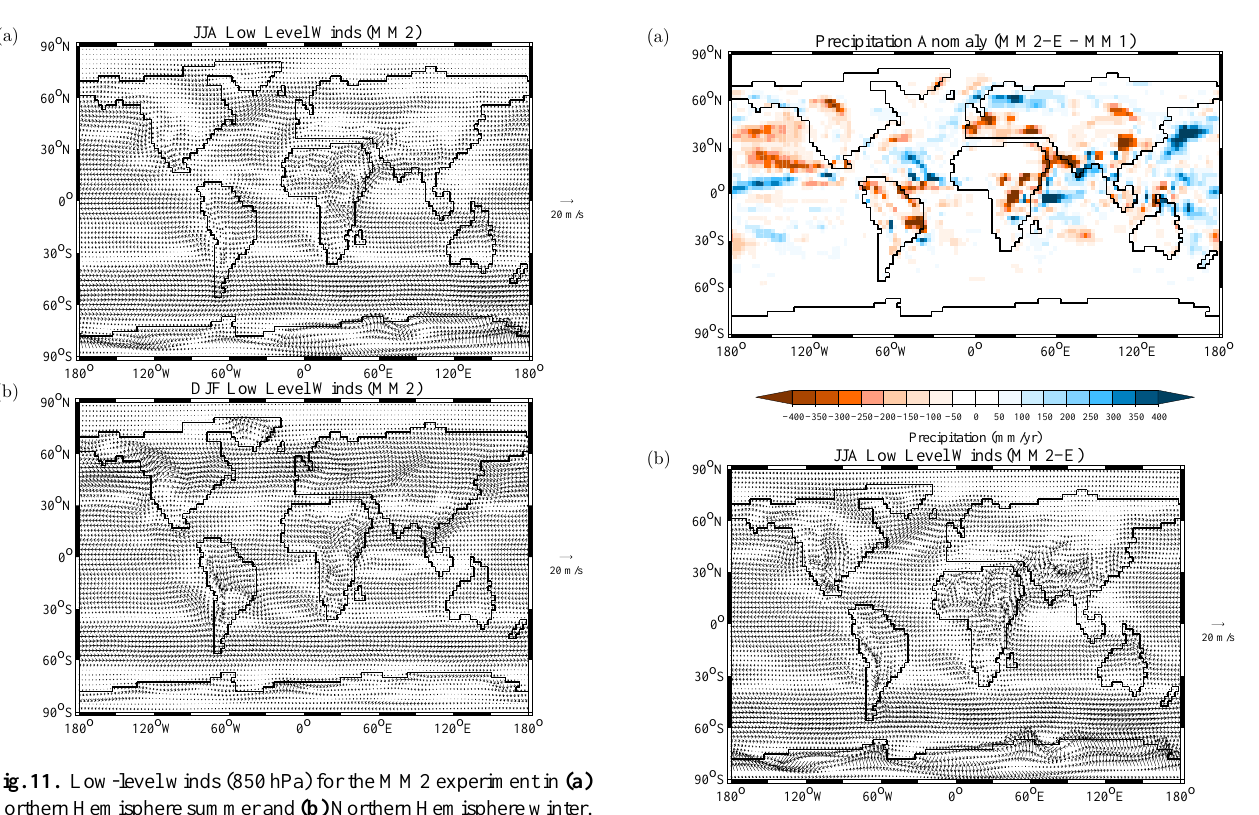
Fig. 12. (a) Annual mean precipitation anomalies (MM2-E–MM1) and (b) Northern Hemisphere summer low-level winds (850hPa) for experiment MM2-E that considers a reduced topography only in